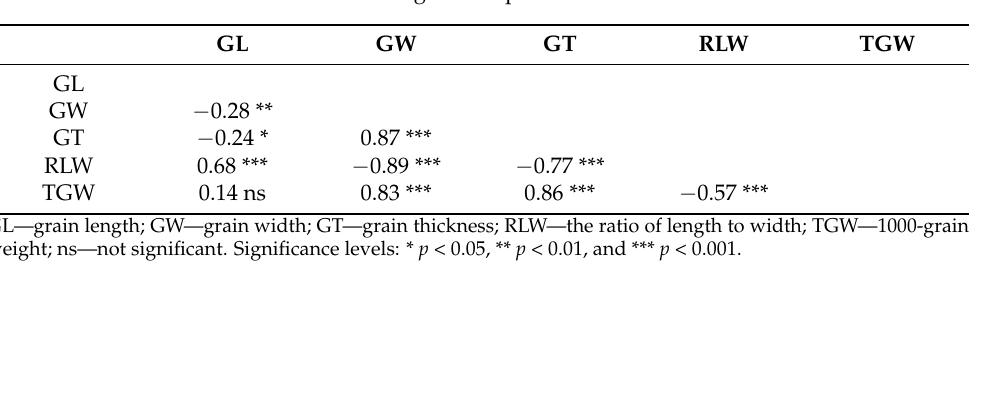
Table 1. Correlation of five traits related to grain shape.